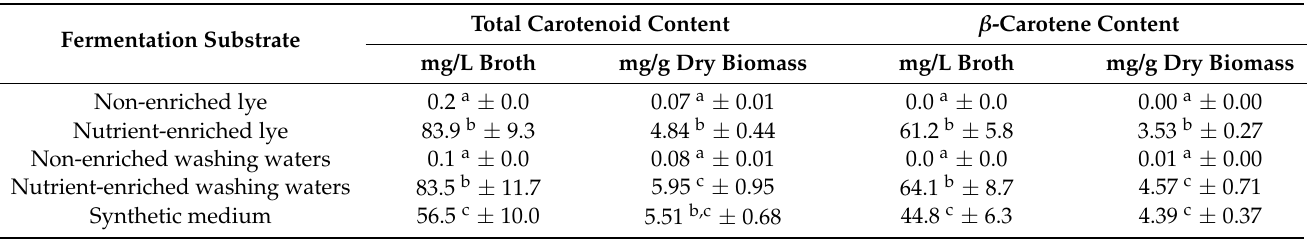
Table 2. Maximum total carotenoid and β -carotene production by B. trispora grown in non-sterile lye and washing waters without or after enrichment with nutrients as well as in synthetic medium (fermentation time: 6 days) 1 .